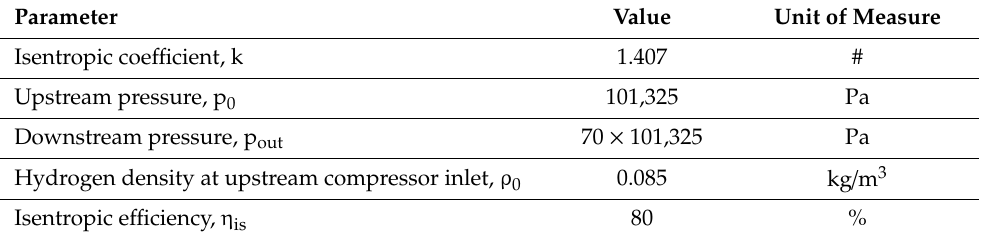
Table 4. Data used for the calculation of the isentropic compression work. Parameter